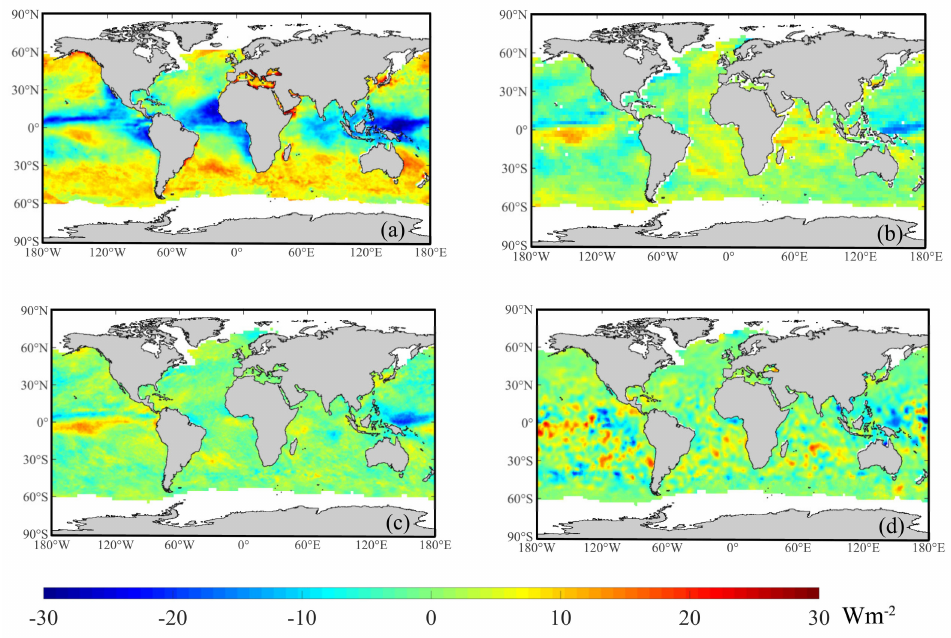
Figure 7. The differences between the average annual mean sea-surface R n values in 1998/1999 and in 2000/2001 for the ( a ) J-OFURO3, ( b ) ISCCP-FD, ( c ) ERA5, and ( d ) NOCS 2.0